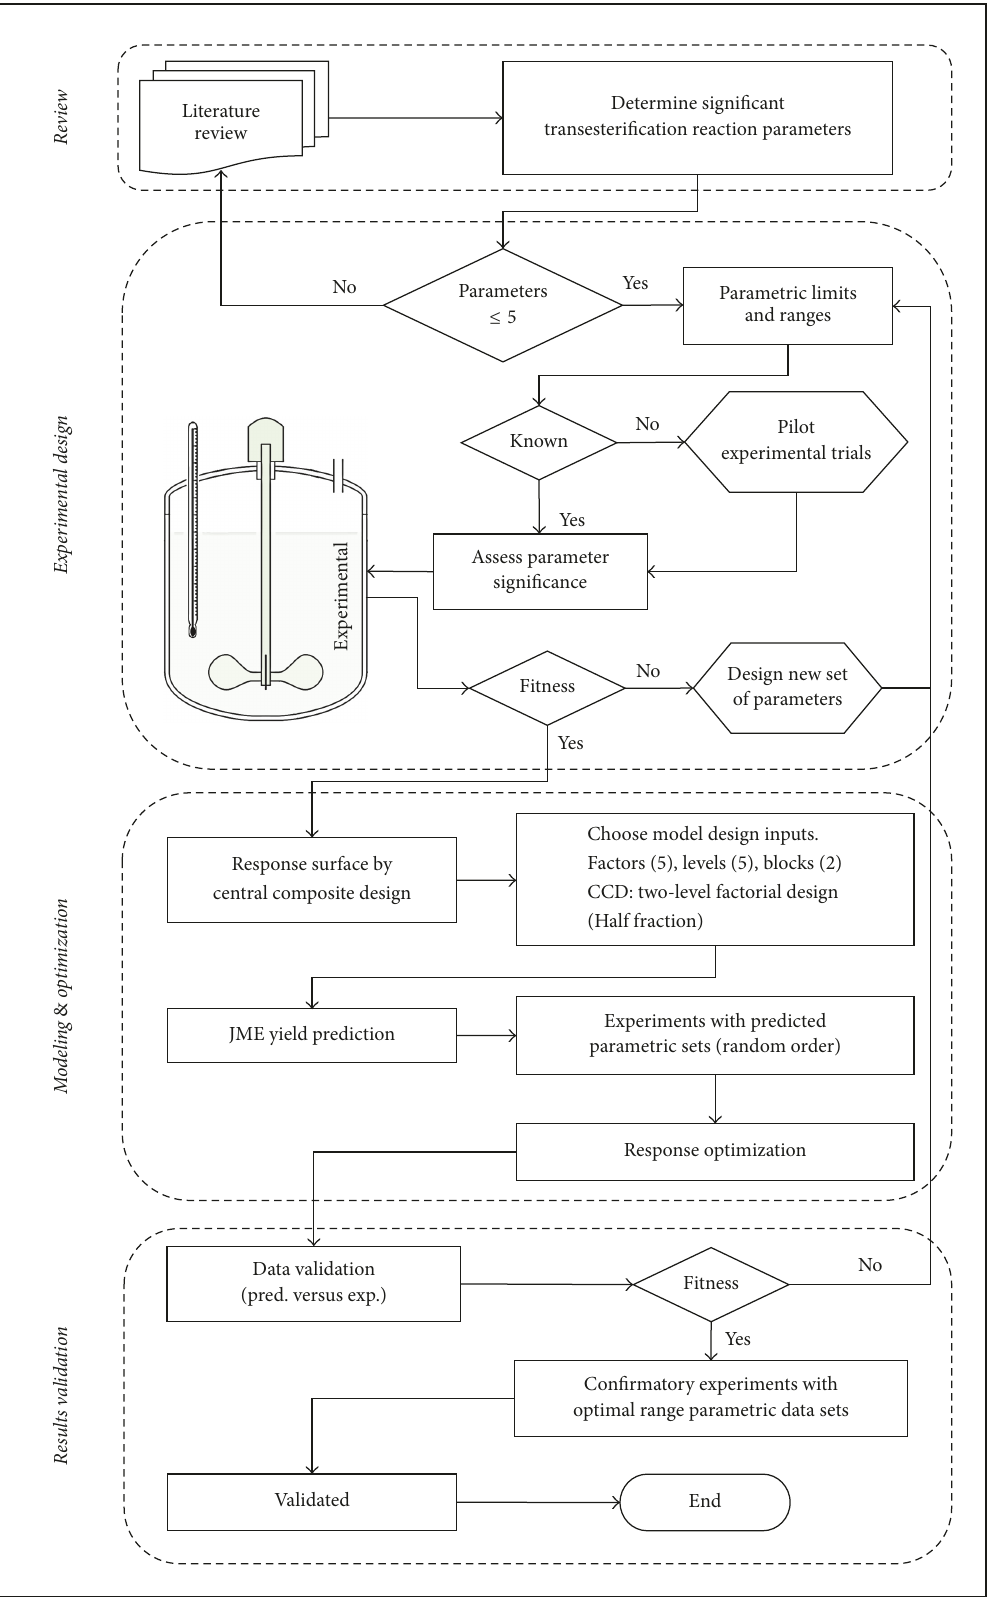
Figure 2: Schematic of optimal JME yield using experimental, modeling, and optimization protocol (customized based on